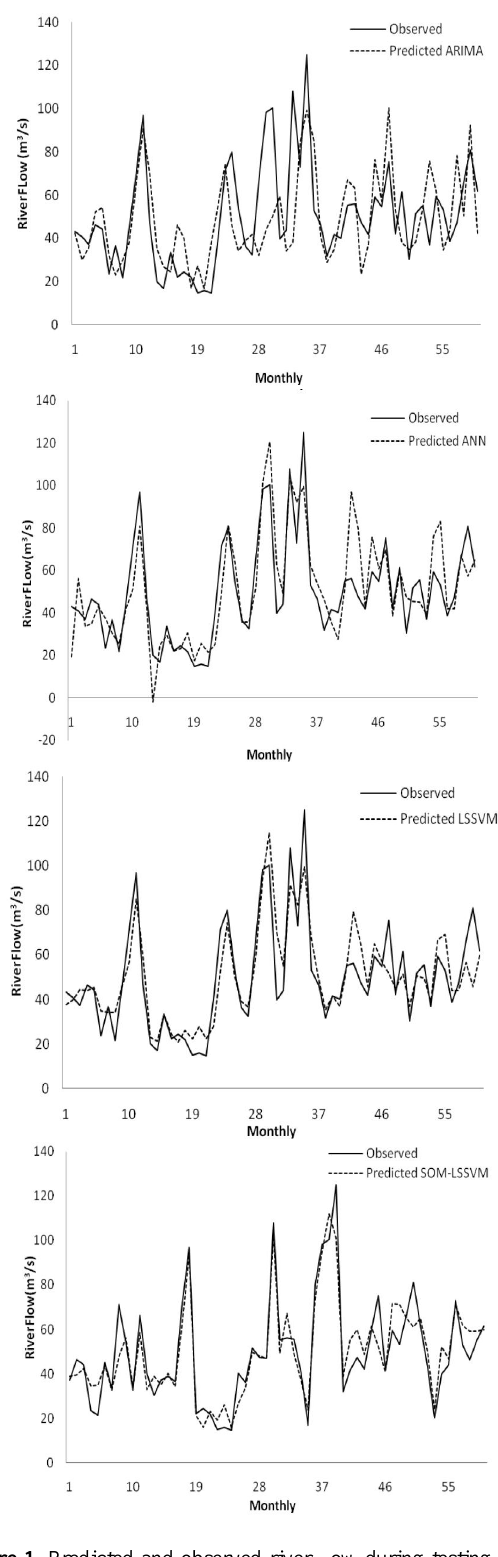
Figure 1. Predicted and observed river flow during testing period by ARIMA, ANN, LSSVM and SOM-LSSVM for Bernam River (Ismail et al.,